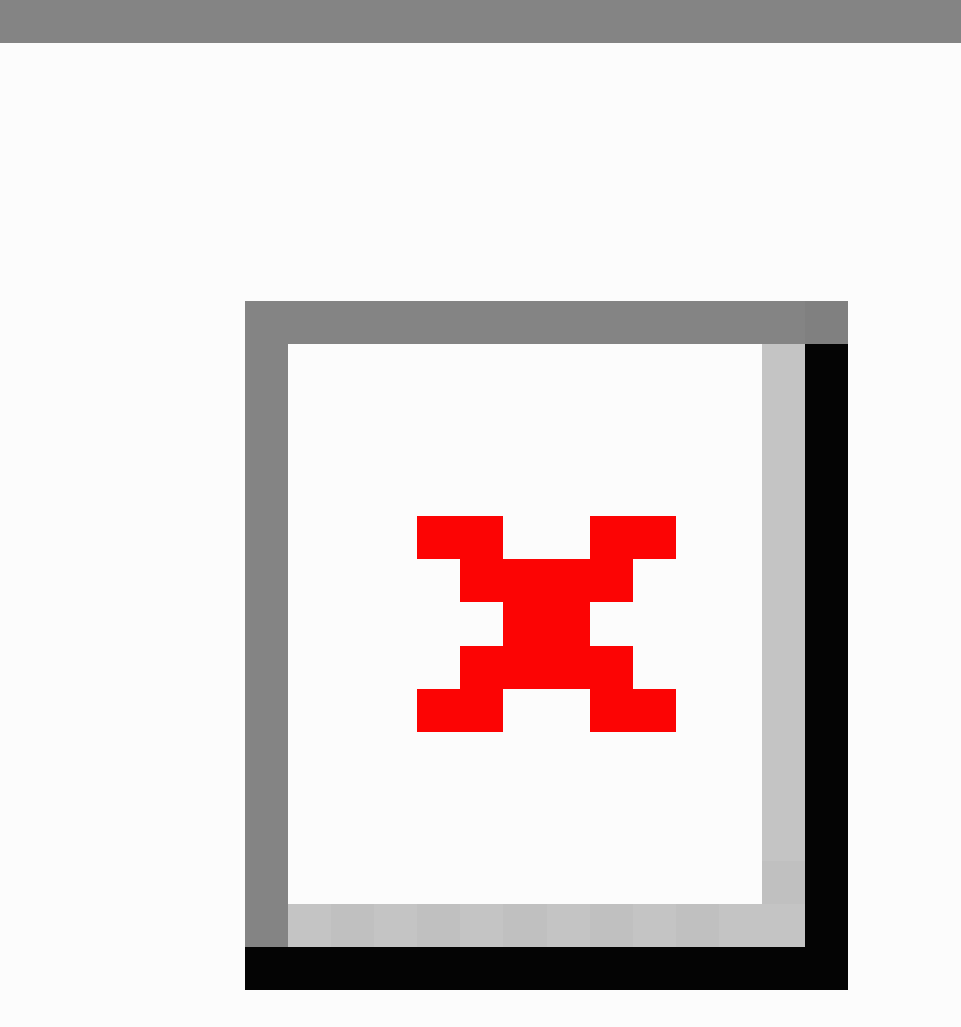
Figure 3. Second Life case screenshots. The user is introduced through a presentation (top image), then proceeds to the case taking cues from chat messages (second top image), and making choices through multiple-choice cards (second bottom image). The simulation involves the user interacting with the patient both in the office environment and on the dental chair (bottom